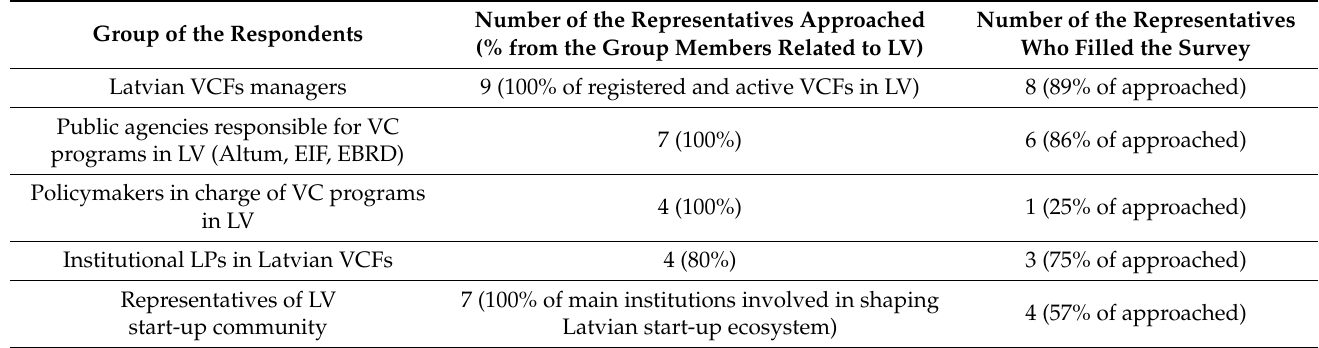
Table 3. Respondents of the questionnaire.